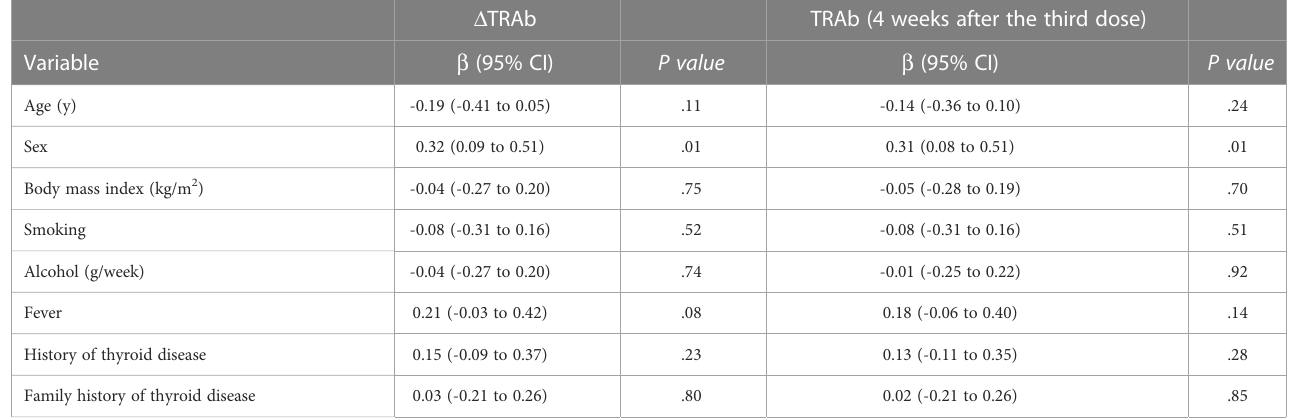
TABLE 2 Univariate analysis for increases of TRAb ( D TRAb) and TRAb 4 weeks after the third dose vaccine (n = 70). D